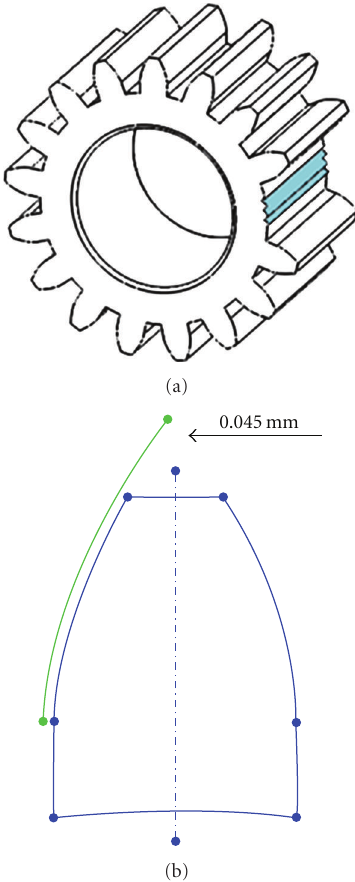
Figure 3: Geometric defects including (a) chipped tooth of Gear A and (b) eccentric tooth of Gear